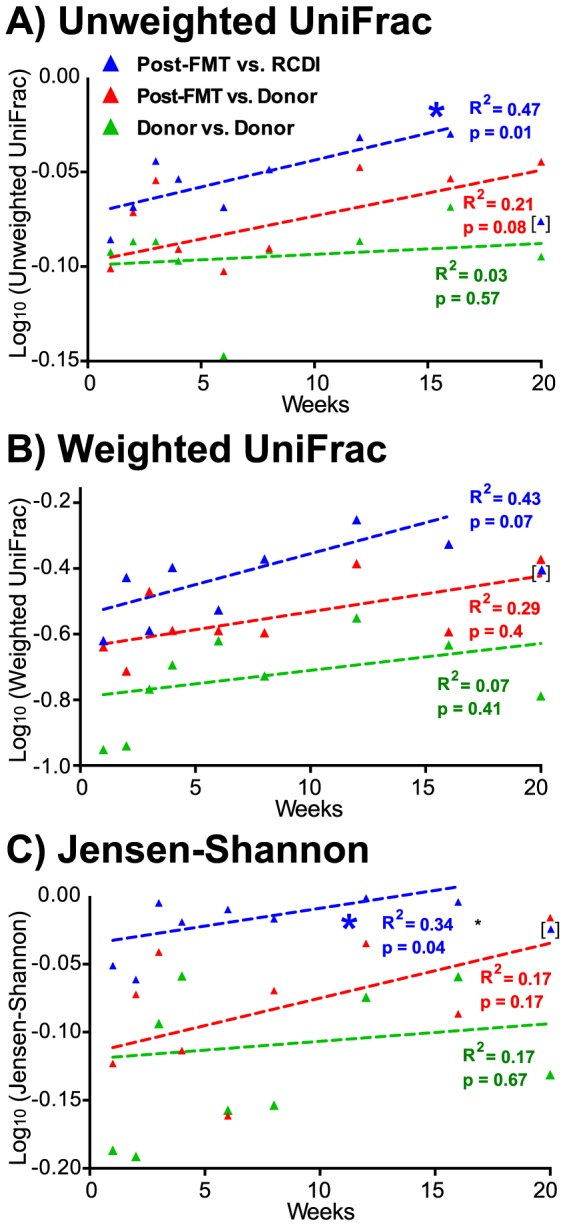
Post-FMT microbiota changes.Unweighted (A) and weighted (B) UniFrac distances and Jensen-Shannon divergence (C) metrics were calculated between post-FMT and RCDI patient sample pairs (red), post-FMT patient and donor sample pairs (green) and between donor sample pairs collected over time (blue) and plotted on logarithmic scales. R2 values and p-values to establish whether the slope of the curve was significantly different from zero are shown with asterisks indicating significance (p<0.05, F-test). The 20-week data point of patient #8 was classified as outlier and not included in the analyses, based on the Bonferroni-adjusted outlier test, and is shown with parentheses. One-year time points (patient and donor #1) were also classified as outliers and omitted from the analysis and plot. A plot showing all data points including those omitted is part of the supplement (Fig. S4).